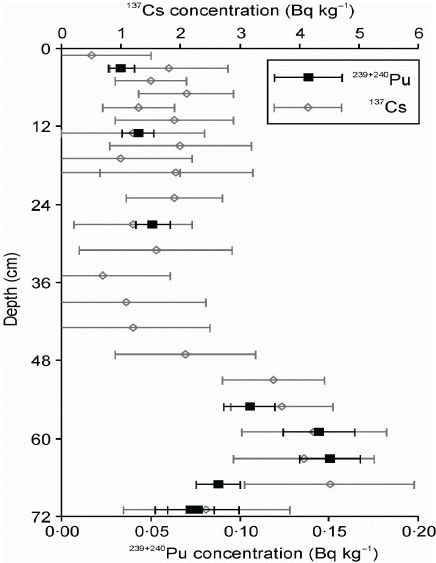
Fig. 3 Comparison of the depth profiles of 239+240 Pu and 137 Cs concentrations associated with a core collected from the floodplain of the Fitzroy River, northeastern Australia. Measurement uncertainty at the 95 per cent confidence limit is indicated (based on Amos et al., 2009). variable through time, because of the assumptions used in the modelling of the decay